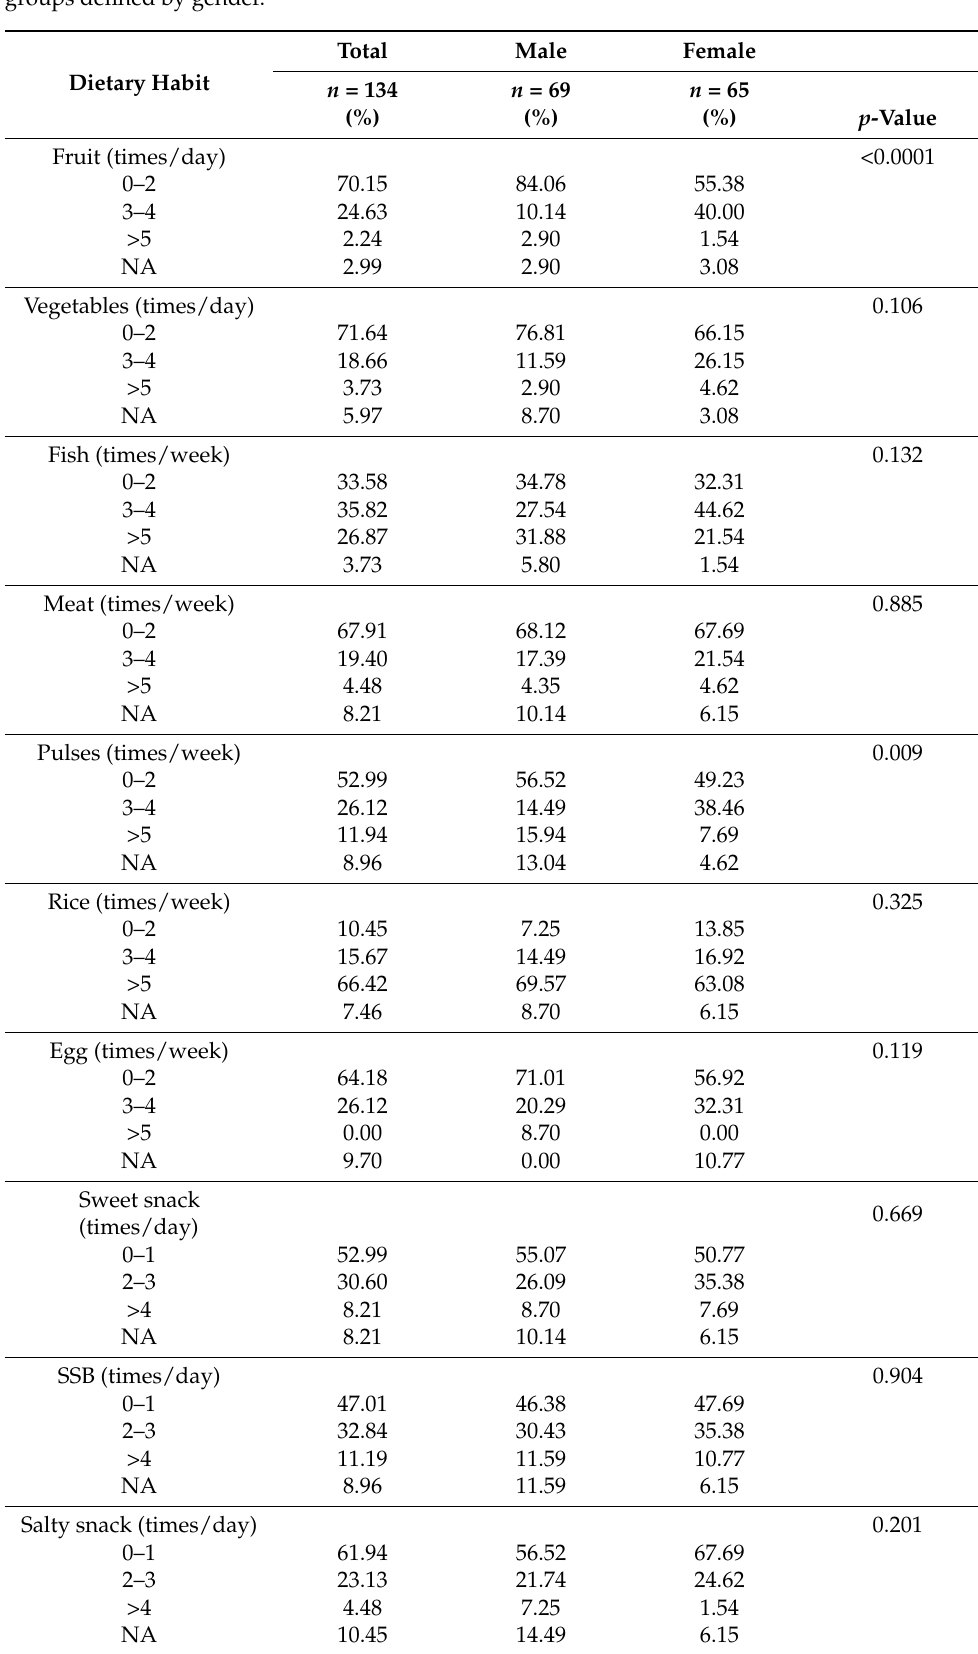
Table 3. Analysis of the children’s eating habits at the time of the visit in the whole population and in groups defined by